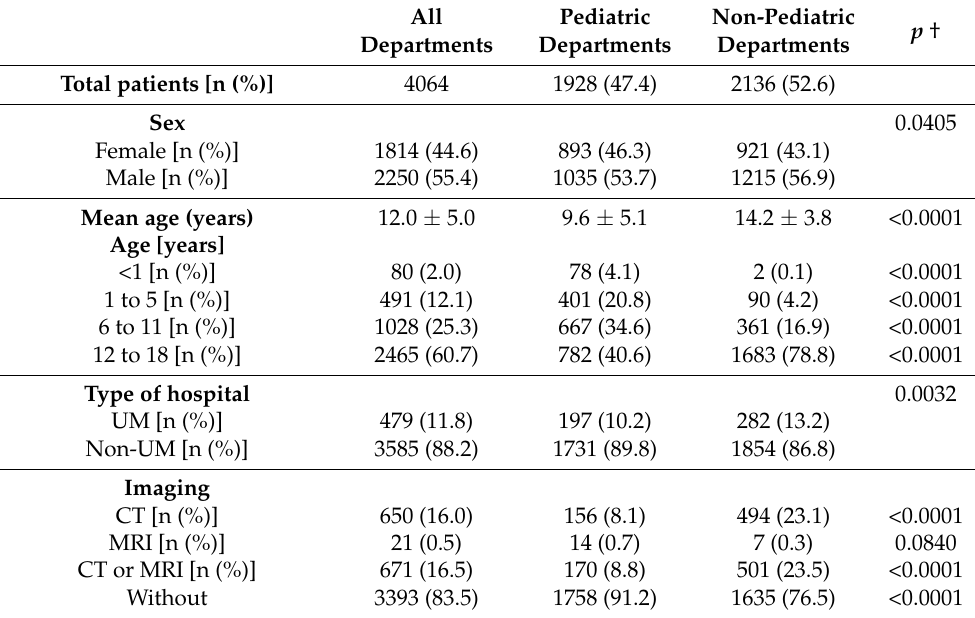
Table 1. Patient characteristics (pediatric departments/non-pediatric departments).